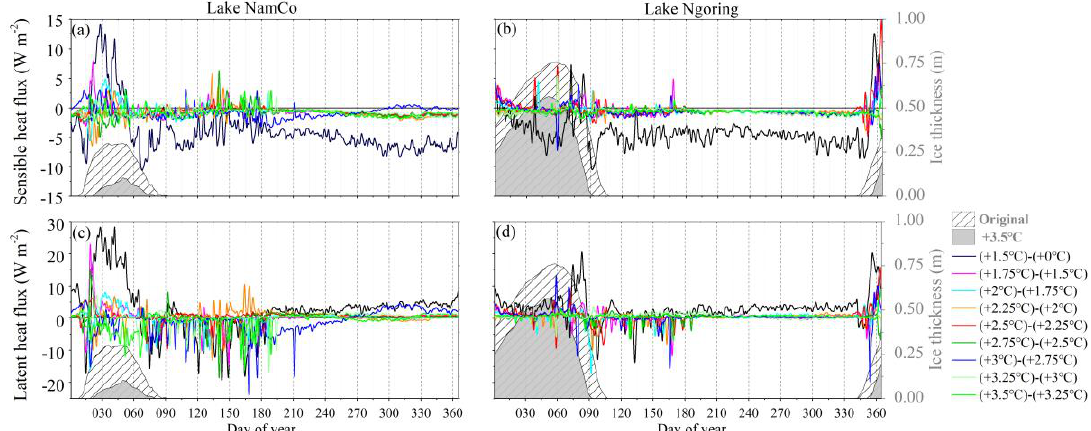
Figure 7. Seasonal variations in lake ice thickness (shading), and differences between the sensitivity of H and LE to different air temperature increases (lines), averaged from January 2012 to December 2016 ( a, c ) at Lake Nam Co and ( b, d ) at Lake Ngoring. The plotted differences are the differences between the sensitivities found for different air temperature changes, as detailed in the legend, i.e., (+1.5 °C) – (+0 °C) refers to the difference between the sensitivity found for a temperature increase of 1.5 °C, and for a temperature increase of 0. The y coordinates for each line show how much the variable has changed within this air temperature increase interval. The gray-shaded area and the left-slash-filled area show the simulated values for no change in air temperature, and for an air temperature increase of 3.5 °C, respectively.